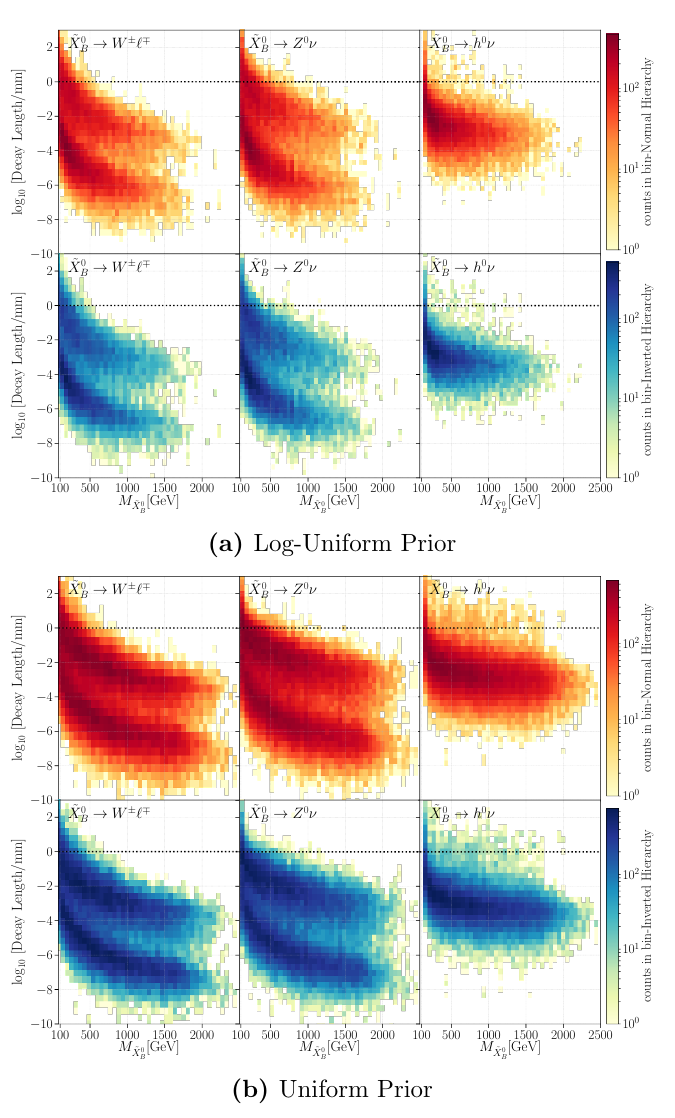
Figure 19. Bino neutralino LSP partial decay lengths in millimeters, for individual decay channels, for both normal and inverted hierarchies and for (a) log-uniform prior and (b) uniform prior. We have chosen (cid:18) 23 = 0 : 597 for the normal neutrino hierarchy and (cid:18) 23 = 0 : 529 for the inverted hierarchy. At and below the blue dashed line ( c(cid:28) = 1 mm), the decays are considered prompt.